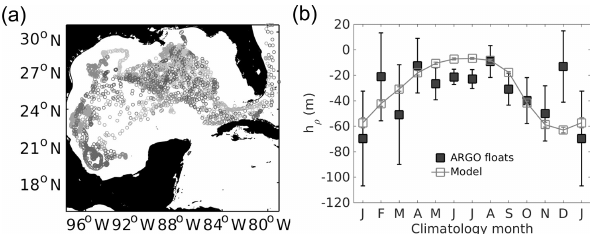
Figure A3. (a) Location of the 2629 ARGO profiles used to compute the mixed-layer depth ( h ρ , m). (b) Climatology comparison of mixed- layer depths for ARGO profile floats (black boxes) and the model (grey boxes). Vertical lines in the boxes denote standard